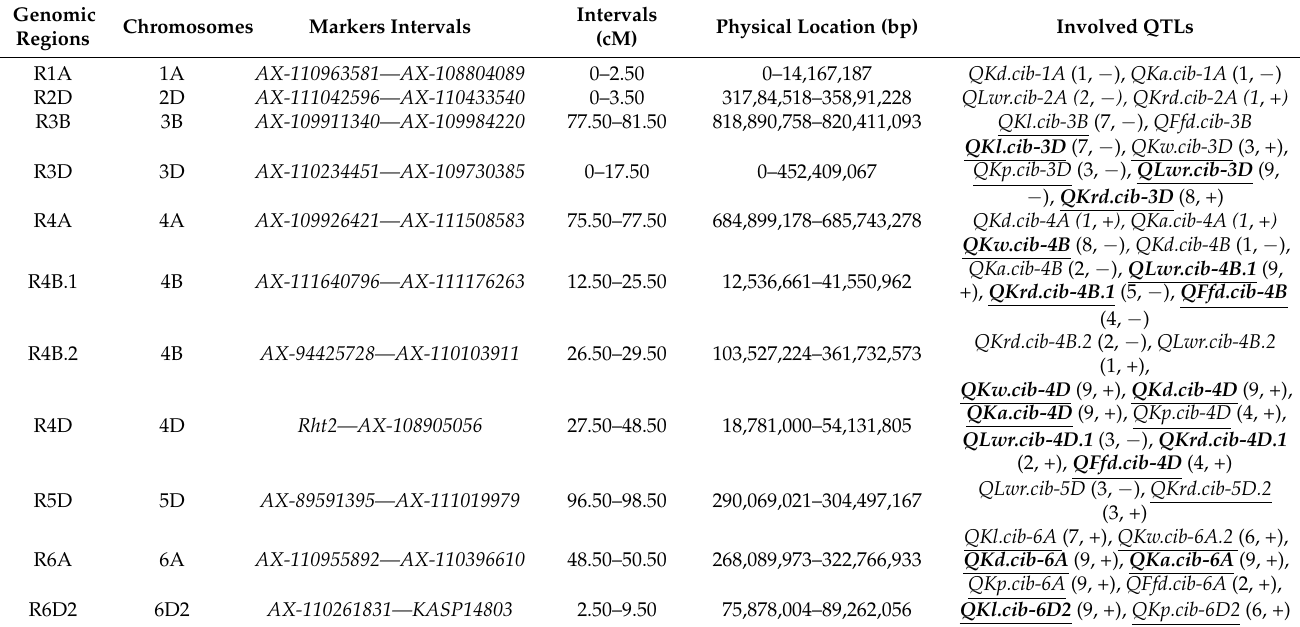
Table 3. Eleven genomic regions harboring two or more QTLs in this